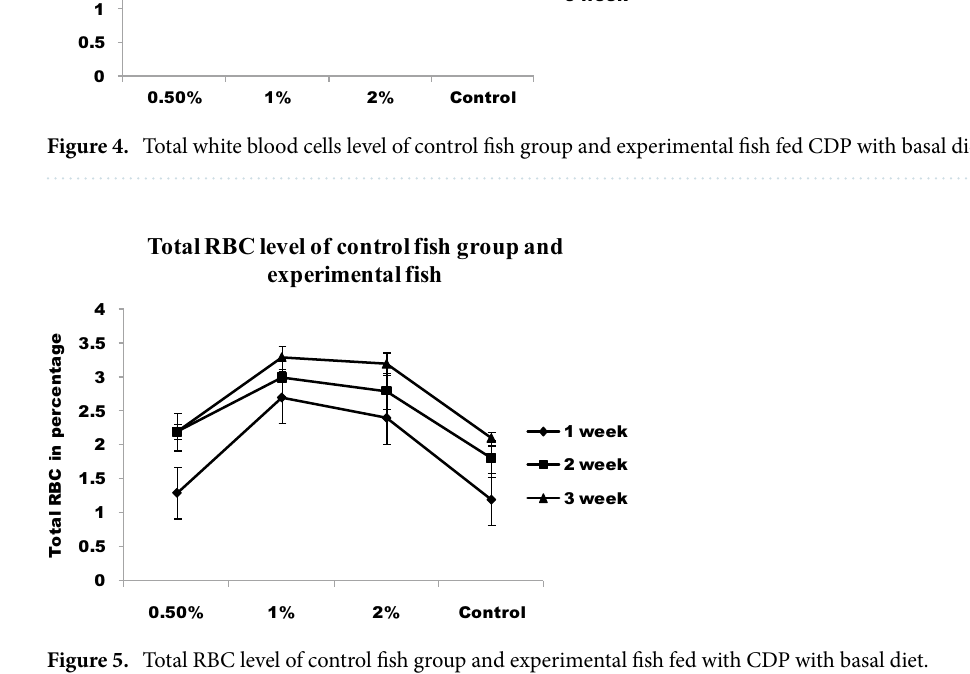
Figure 5. Total RBC level of control fish group and experimental fish fed with CDP with basal